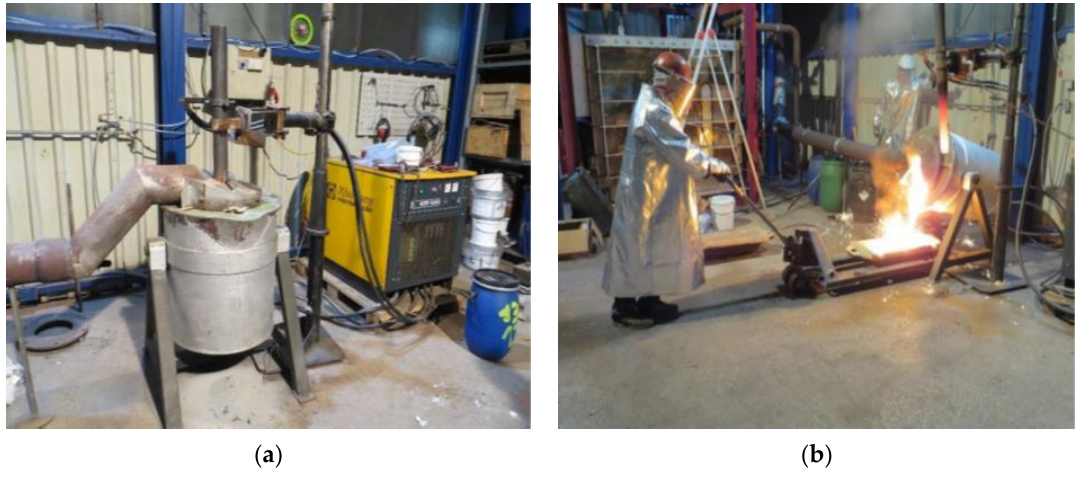
Figure 3. EAF during operation ( a ) and tapping ( b ).